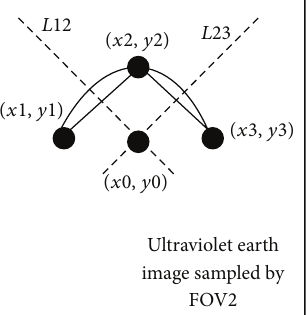
Figure 6: The arc image of ultraviolet